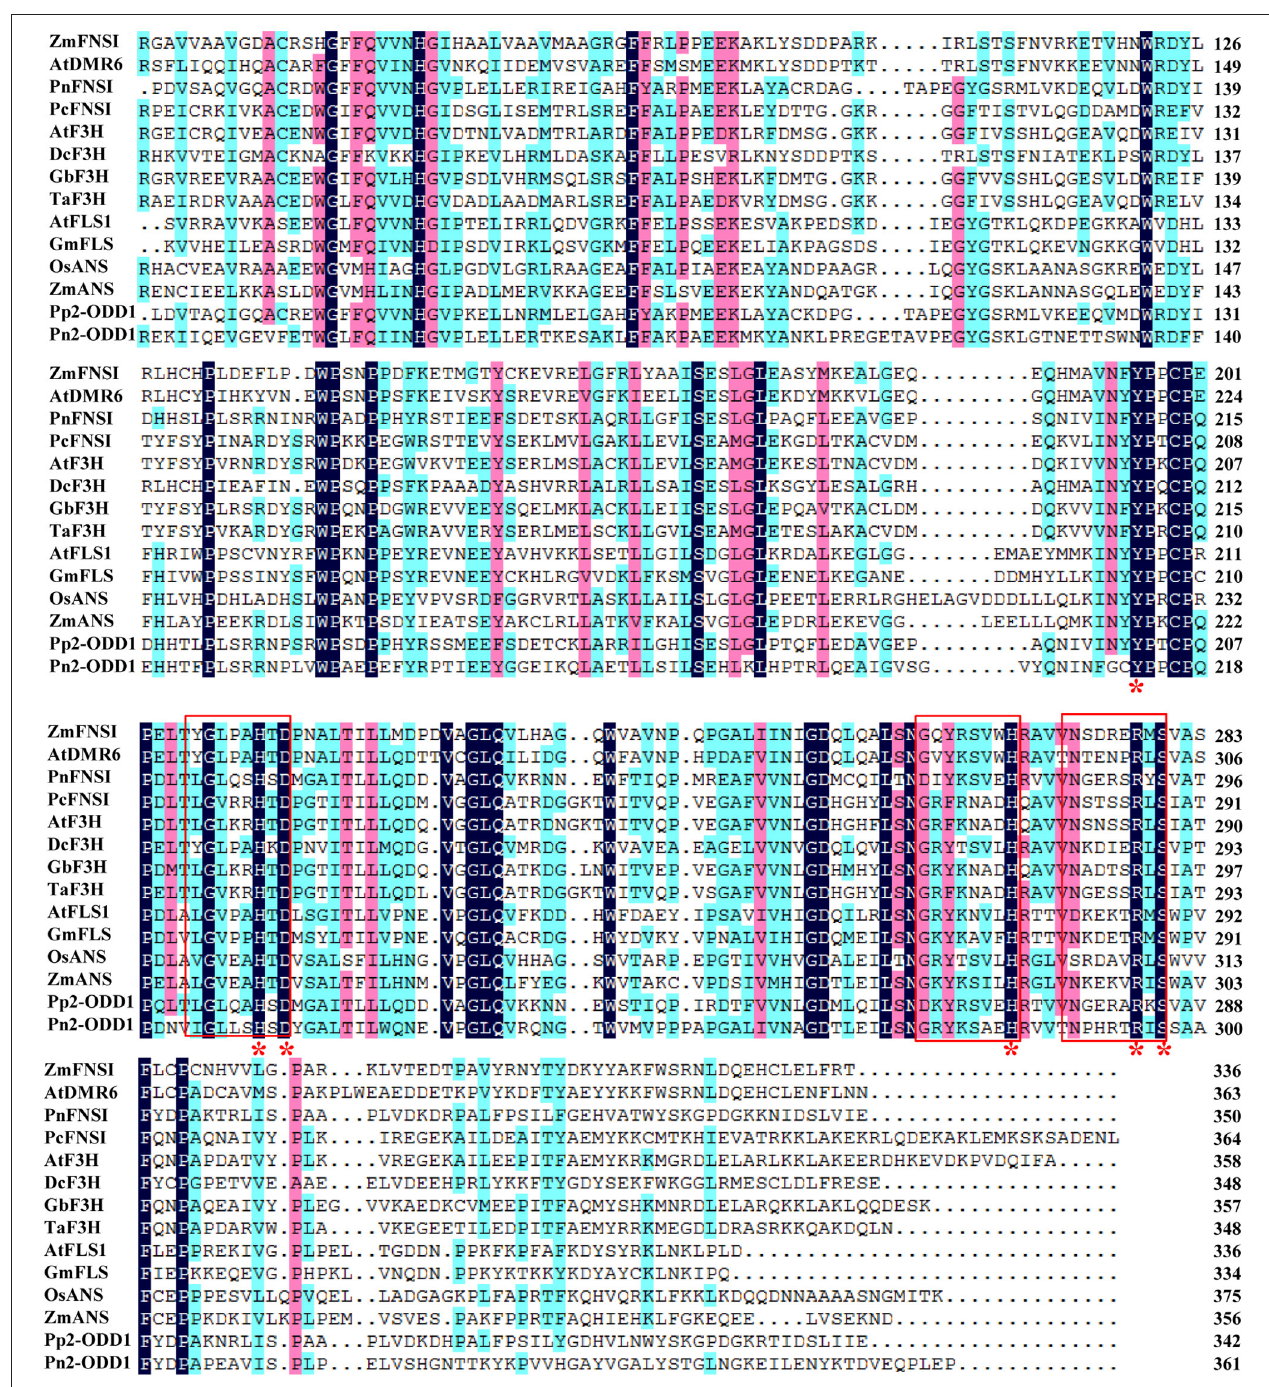
FIGURE 1 | Pn2-ODD1 shared homology with other known species 2-ODDs. The amino acid sequence alignment of Pn2-ODD1 with 2-ODDs protein from other species. Red frames indicated ferrous iron binding site HXDX55H and 2-oxoglutarate (2-ODD) binding site RXS. Red asterisks (*) indicated the conserved amino acid residues of 2OG-FeII_Oxy conserved domain. Zea mays , ONL99521.1_ZmFNSI1; Arabidopsis thaliana , Q9FLV0.1_AtDMR6; Pohlia nutans , QCP71067.1_PnFNSI; Petroselinum crispum , AAP57393.1_PcFNSI; Arabidopsis thaliana , NP_190692.1_AtF3H; Dendrobium catenatum , PKU66857.1_DcF3H; Ginkgo biloba , AAU93347.1_GbF3H; Triticum aestivum , AFJ38181.1_TaF3H; Arabidopsis thaliana , NP_001190266.1_AtFLS1; Glycine max , NP_001237419.1_GmFLS; Oryza sativa , CAA69252.1_OsANS; Zea mays , and NP_001106074.1_ZmANS; Physcomitrella patens , XP_001780809.1_Pp2-ODD1.